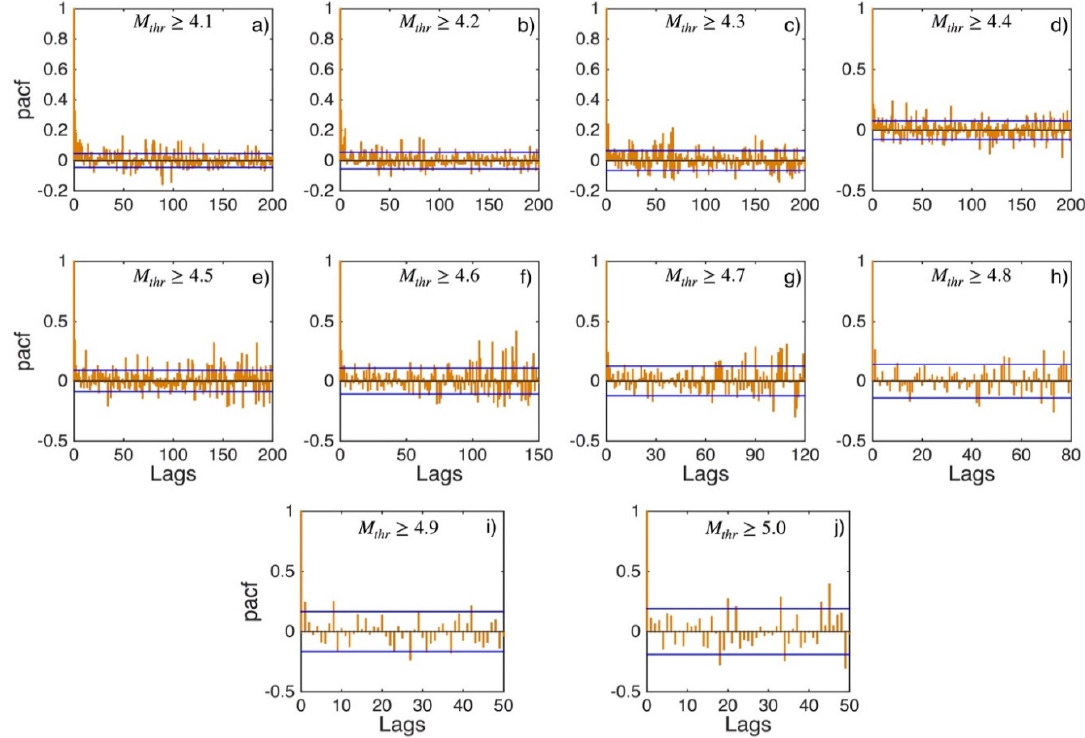
Figure A23. PACF values (orange stems) and their 95% confidence intervals (blue lines) for North Aegean Sea (sub − area 9) for magnitude thresholds ( M thr ) varying from 4.1 to 5.0 (subplots a – j ).